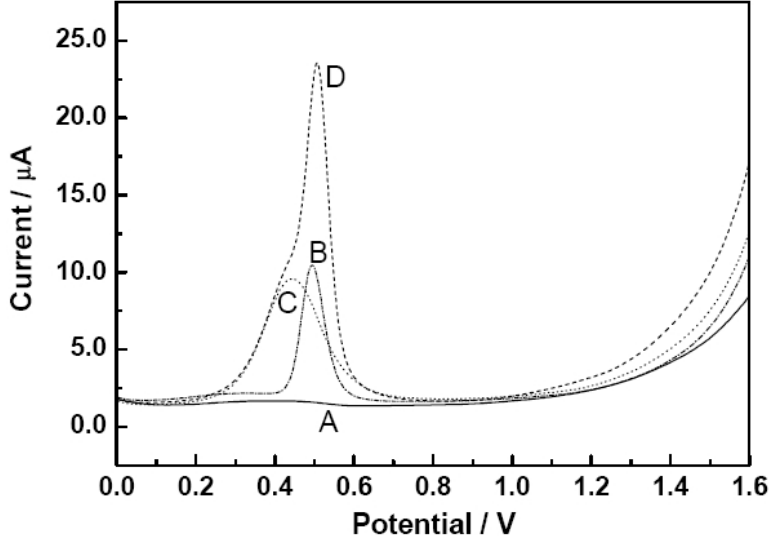
Fig. 3 DPVs obtained on GC electrode in 0.1 M HclO 4 solution(A), A+ 1 × 10 − 4 M DA (B), A+1 . 0 × 10 − 3 M AA (C), and A+ 1 × 10 − 4 M DA +1 . 0 × 10 − 3 M AA (D) (The increment E: 0.004 V; Amplitude: 0.05 V; Pulse width: 0.05 s; Pulse period: 0.2